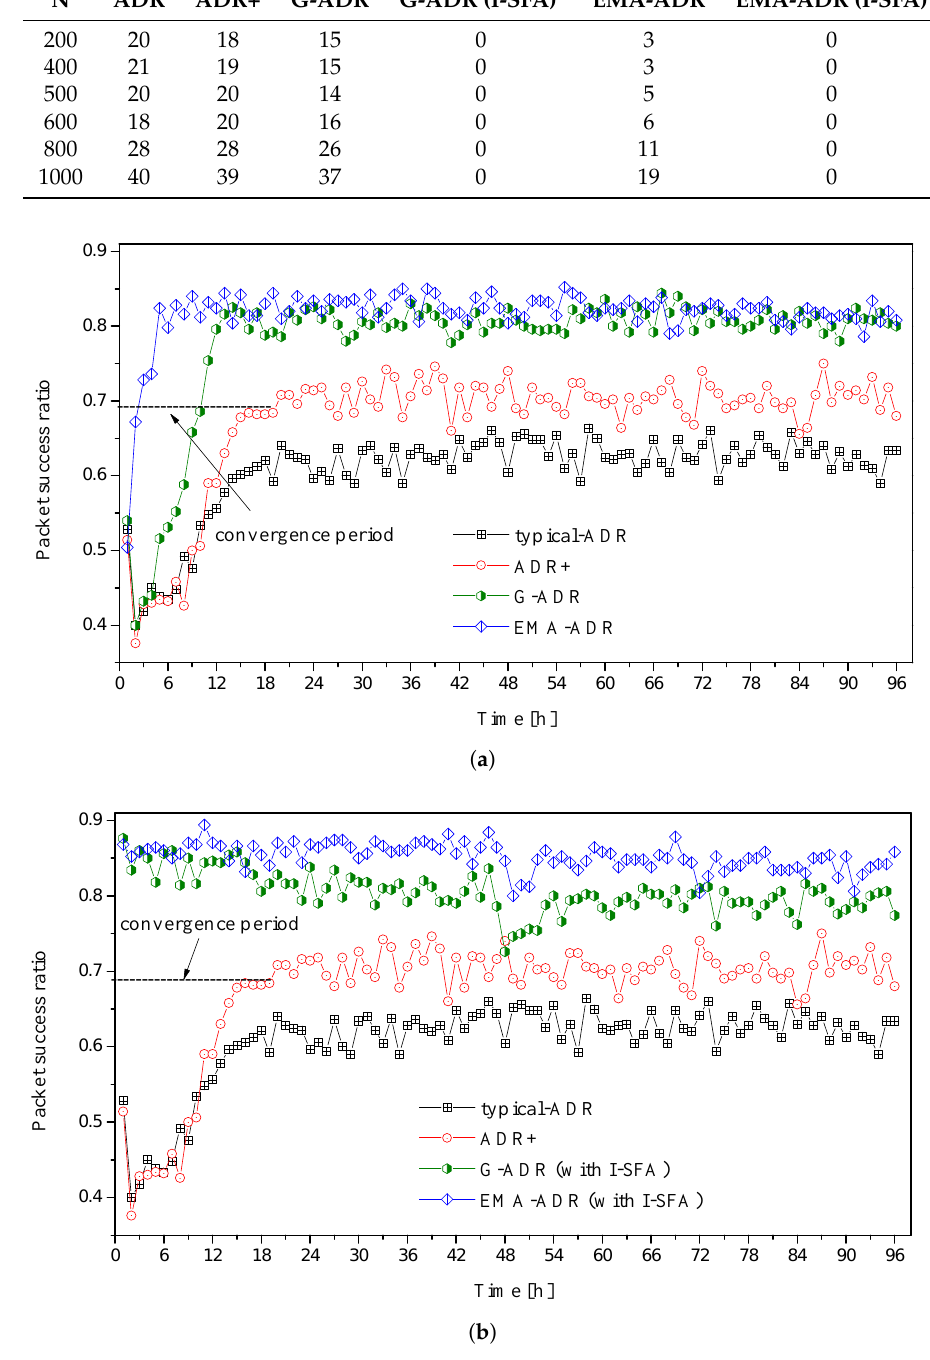
Figure 8. Convergence period and PSR of static EDs with N = 500: ( a ) initial allocation of SF with 12, and ( b ) initial allocation of SF with 12 (for ADR and ADR+) and initial SF allocation with I-SFA (for G-ADR and